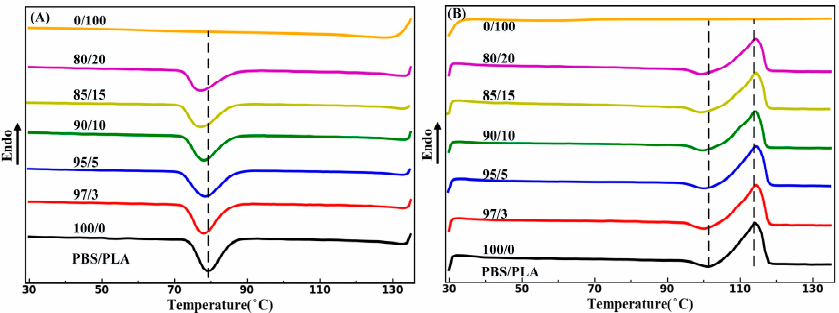
Figure 7. DSC curves of the neat PBS, PLA and the as-extruded PBS/PLA composites with various PLA concentrations: ( A ) first cooling curves and ( B ) second heating curves. Table 1. DSC parameters of PBS phase in neat PBS, PLA and the as-extruded PBS/PLA composites.